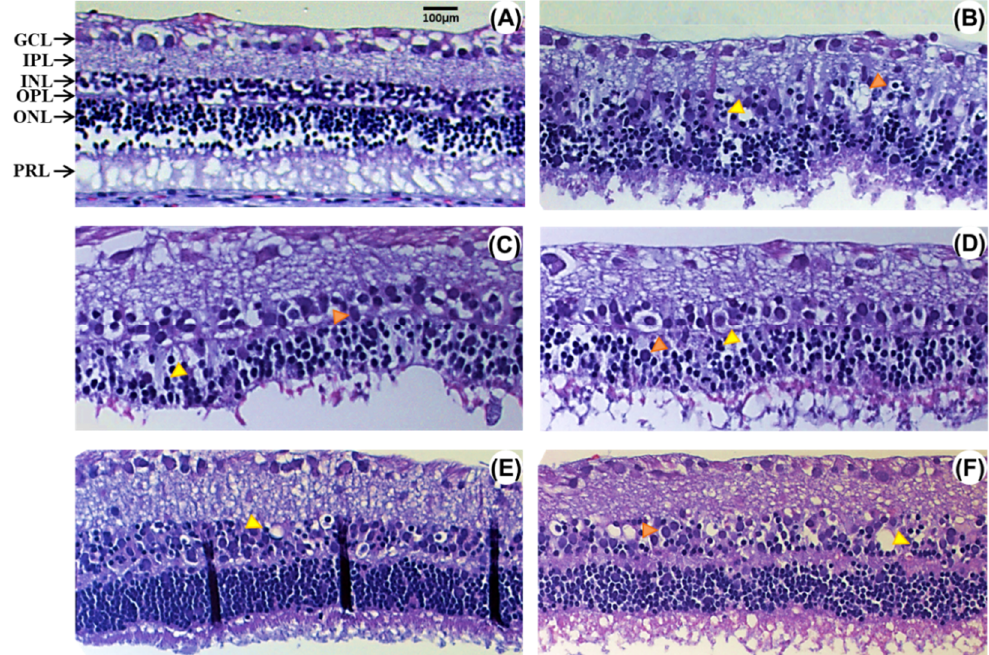
Figure 1. Effect of several concentrations of epigallocatechin 3-gallate (EGCG) on morphological changes induced by retinal ischemia/reperfusion (rI/R). ( A ) Sham group; ( B ) vehicle-treated rI/R (rI/R-veh); ( C ) treated with EGCG at 1.5 (rI/R-E1.5); ( D ) at 7.5 (rI/R-E7.5); ( E ) at 15 (rI/R-E15), and ( F ) at 30 mg/kg (rI/R-E30). Pinocytic nuclei and vacuolization are showed in yellow and orange arrowheads, respectively. Ganglion cell layer (GCL) shows vacuolated cells and nucleomegaly. In the outer plexiform layer (OPL), a vacuolated aspect with an eosinophilic area is observed. IPL, internal plexiform layer; INL, internal nuclear layer; outer nuclear layer ONL; and photoreceptor layer (PRL). Hematoxylin and eosin staining. Scale bar = 100 μm.